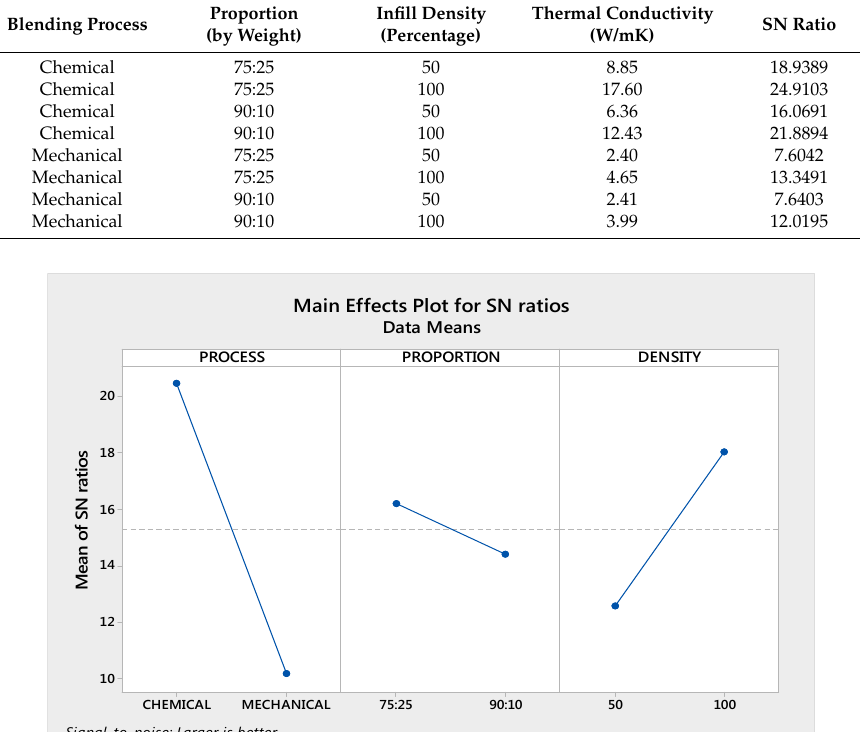
Figure 7. Main effects graph for SN ratios of thermal conductivity.